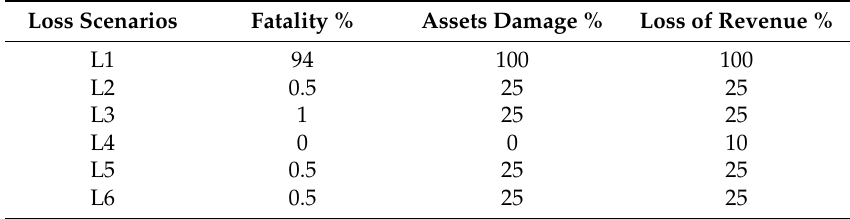
Table 3. Percentage loss for every attack scenario.